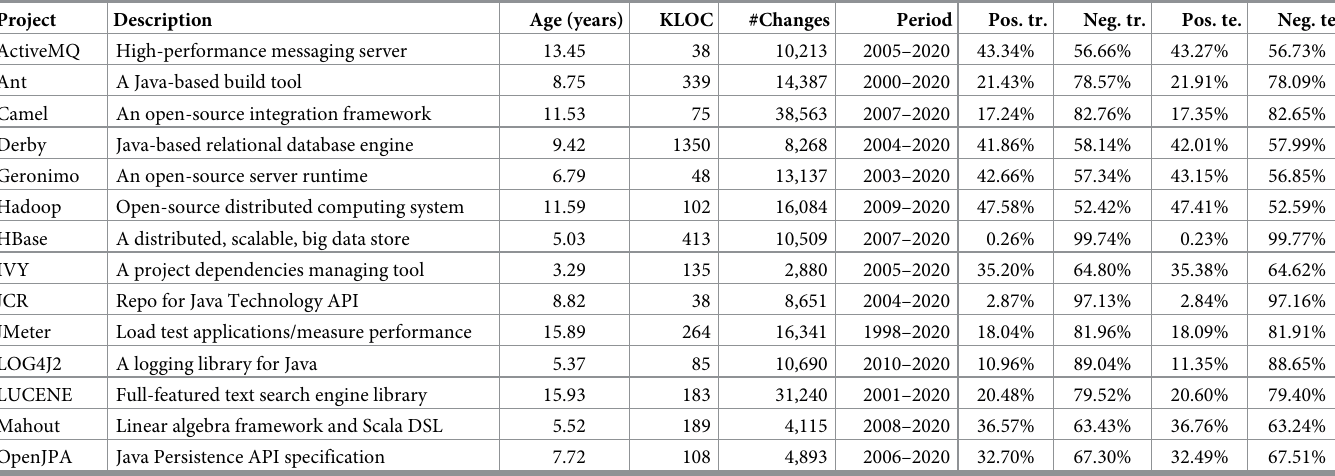
Table 3. The 14 open-source target projects from the